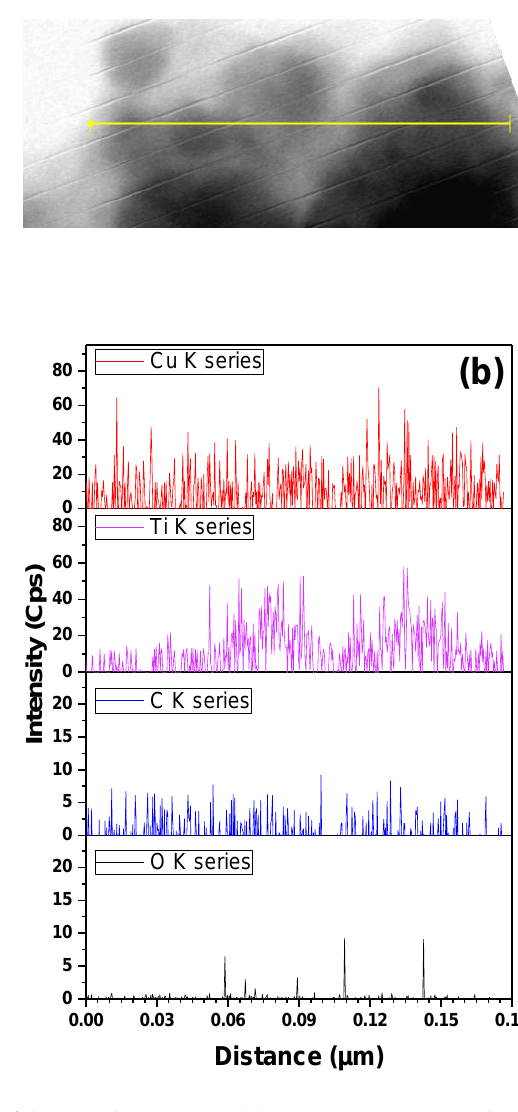
Figure 10. Scanning TEM images and EDS profiles of the 20 vol % TiC–Cu: ( a ) nanocomposite A; and ( b ) nanocomposite B sintered at 900°C.